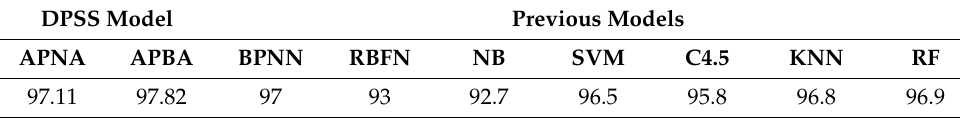
Figure 6. Comparison of our model with other models based on accuracy (CCR). Table 4. Table for comparison of DPSS model with other models based on accuracy (CCR) .